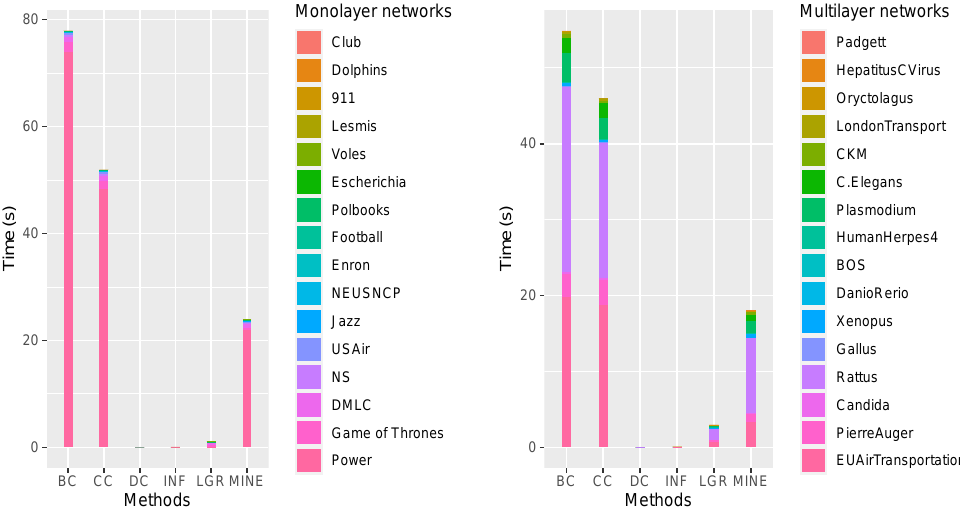
Figure 6. Comparisons of accumulated execution time by performing the competitive measures on the grouped